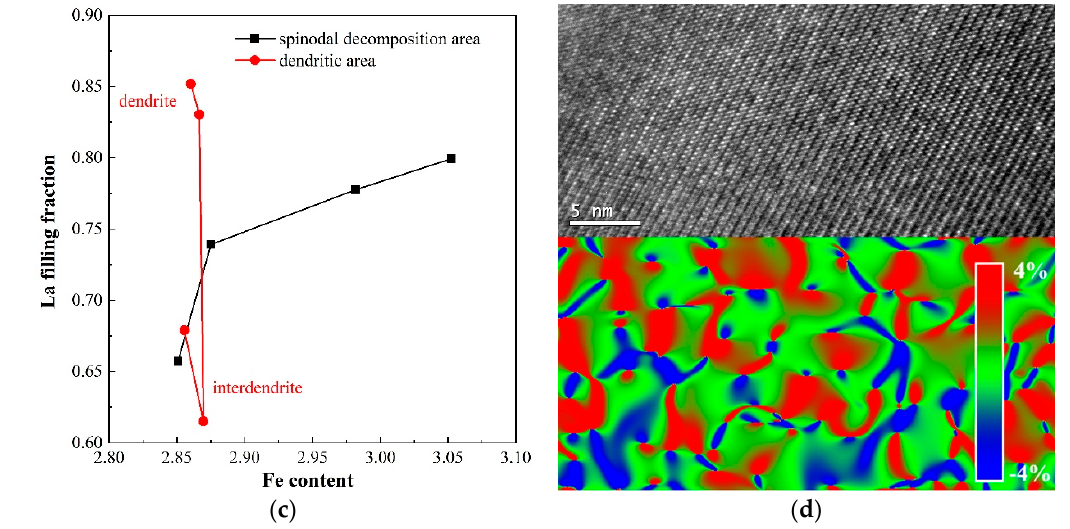
Figure 6. ( a ) The microstructure of the DC hot-pressed samples at low magnification. ( b ) The submicron-scale dendritic segregation and the nanoscale spinodal decomposition zones. ( c ) The La filling fraction in the dendritic segregation and spinodal decomposition zones. ( d ) the high-resolution transmission electron microscopy (HRTEM) image in the grains and the corresponding strain field calculated by the geometrical phase analysis method.